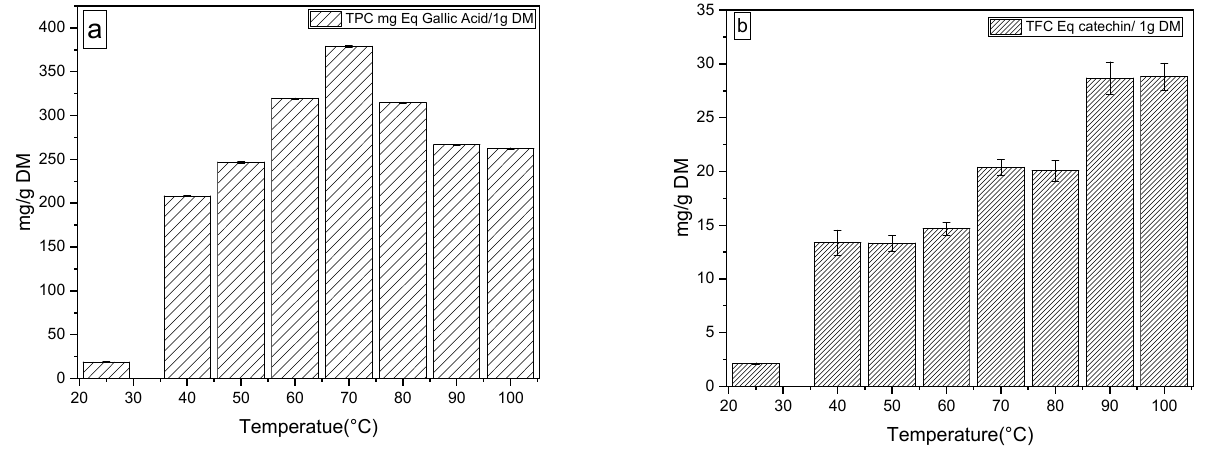
Figure 3. ( a ) Profile of total polyphenols (TPC) and ( b ) total flavonoids (TFC) as a function of